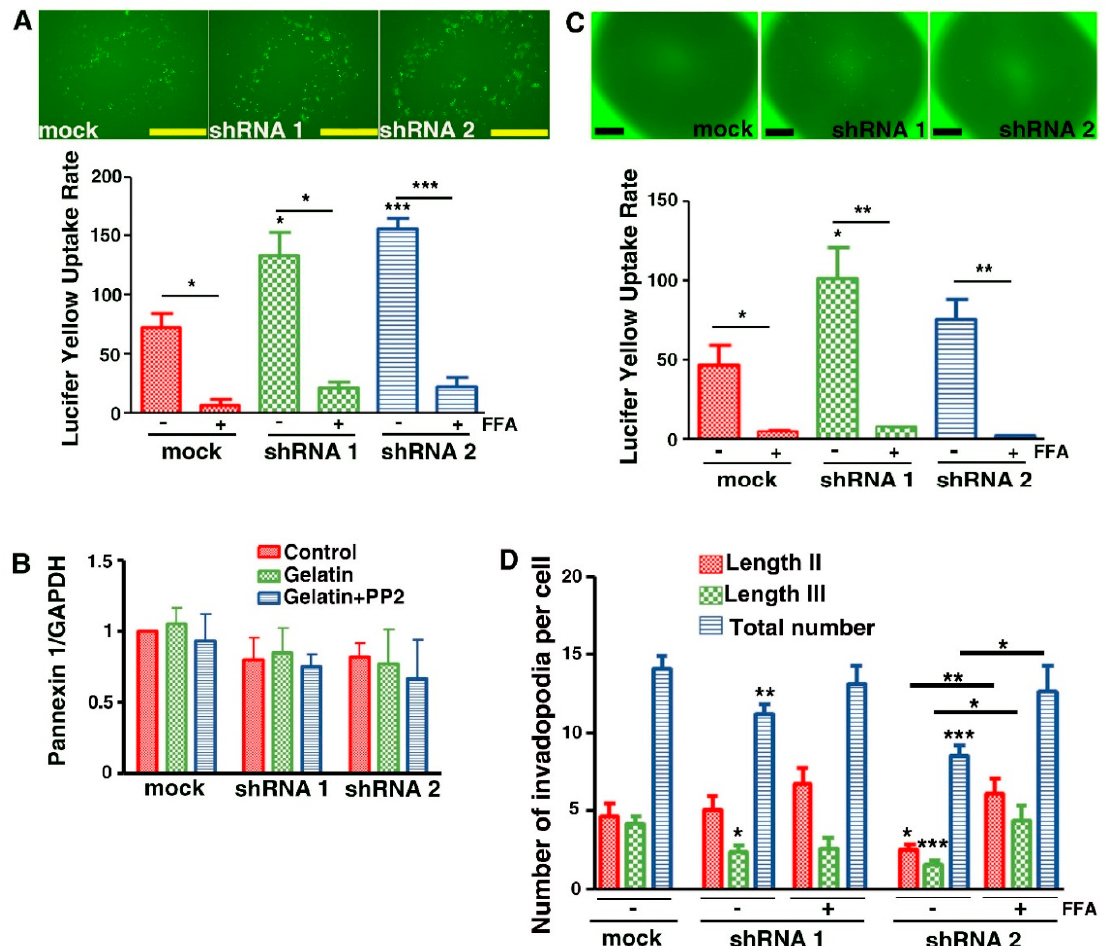
Figure 8. Correlation between increased hemichannel activity and decreased Cx43 expression. U251 cells were cultured on coverslips ( A ) or on inserts ( C ) coated with gelatin for 8 h. Lucifer Yellow (0.5 mg / mL) was added on coverslips or below the inserts permitting its uptake in cells via Cx43 hemichannels. For inserts, only Cx43 hemichannels in invadopodia were accessible to Lucifer Yellow. To determine the specific involvement of Cx43 hemichannel, a Cx inhibitor, flufenamic acid (FFA; 100 µ M), was used. ( A ) Top panel: Representative records of Lucifer Yellow uptake by U251 cells cultured on coverslips coated with gelatin (N = 5) (Scale bar: 50 µ m). Bottom panel: Quantification of Lucifer Yellow uptake depending on Cx43 expression level. ( B ) Densitometric analysis of Pannexin 1 (Panx1) expression levels after normalization by GAPDH expression. Panx1 expression is not significantly modulated in shRNA clones compared to mock cells on plastic (control, red), gelatin (0.2%, green) or gelatin + PP2 (5 µ M, blue) conditions (N = 3). The increase in Lucifer Yellow uptake which is observed is therefore due to Cx43 decrease and not to Panx1. ( C ) Top panel: Representative record of Lucifer Yellow uptake of U251 cells cultured on inserts coated with gelatin (N = 5) (Scale bar: 50 µ m). Bottom panel: Quantification of Lucifer Yellow uptake depending on Cx43 expression level. ( D ) Medium (red), long (green) and total number of invadopodia (blue) per cell was determined according to Cx43 expression level and in presence or not of FFA. Medium invadopodia correspond to the Assembly stage of invadopodia formation (Length II) and long invadopodia correspond to Elongation / Maturation stage of invadopodia formation (Length III). * p < 0.05; ** p < 0.01 and *** p < 0.001. Values shown as mean ± SEM (see Supplementary Table S1).